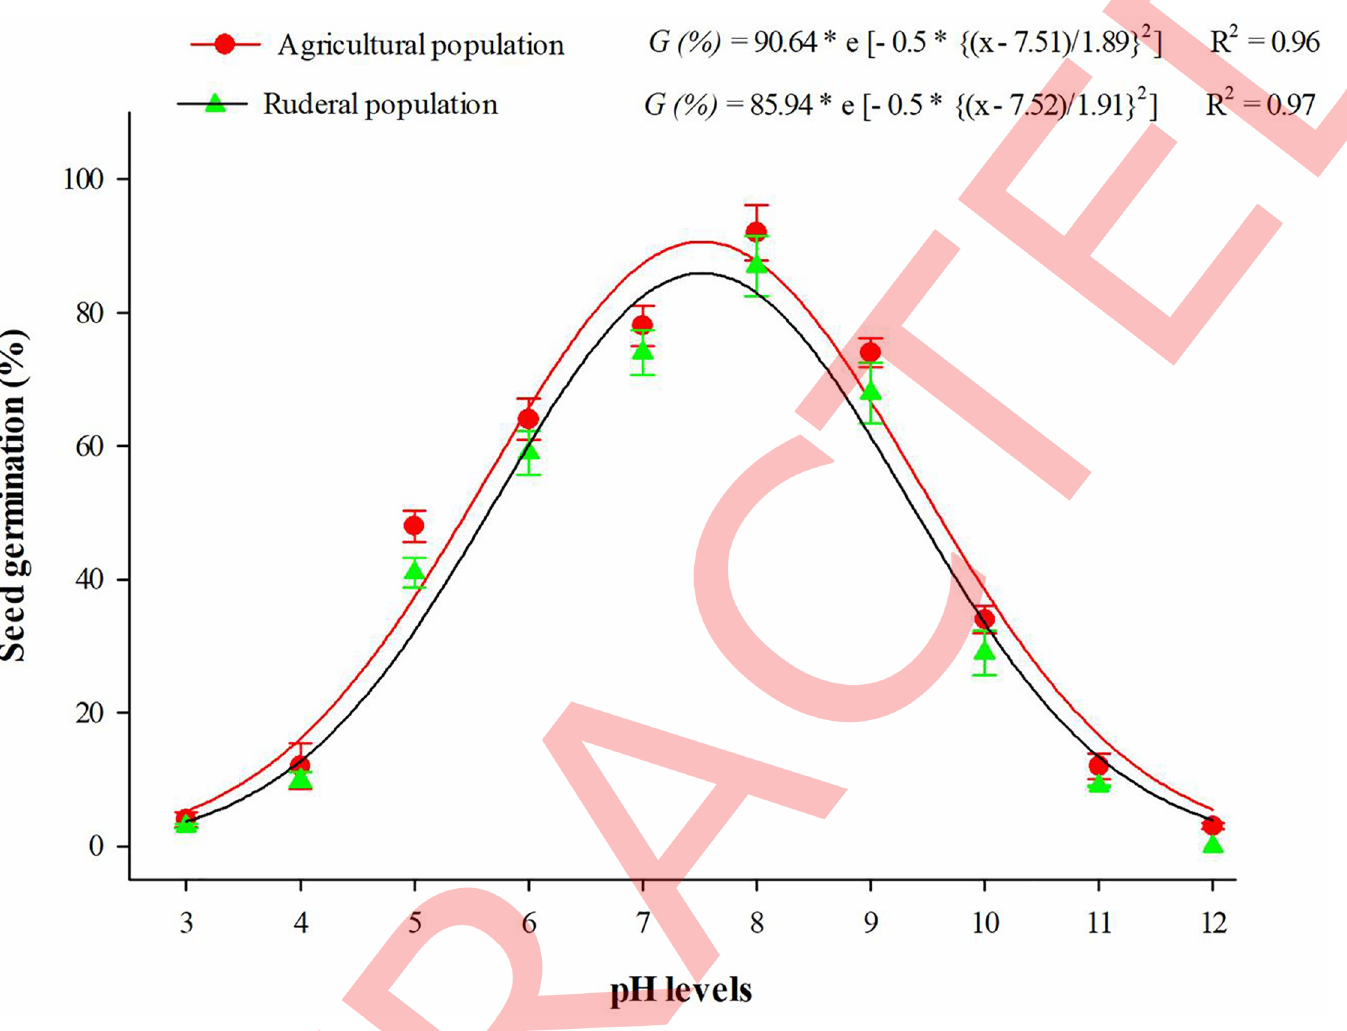
Fig 3. The influence of different levels of pH on seed germination percentage of ruderal and agricultural populations of Xanthium strumarium L.